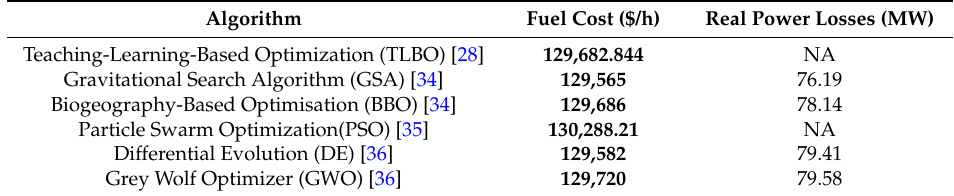
Table 7. Comparison of the solutions obtained for cost reduction (standard IEEE 118-bus network).